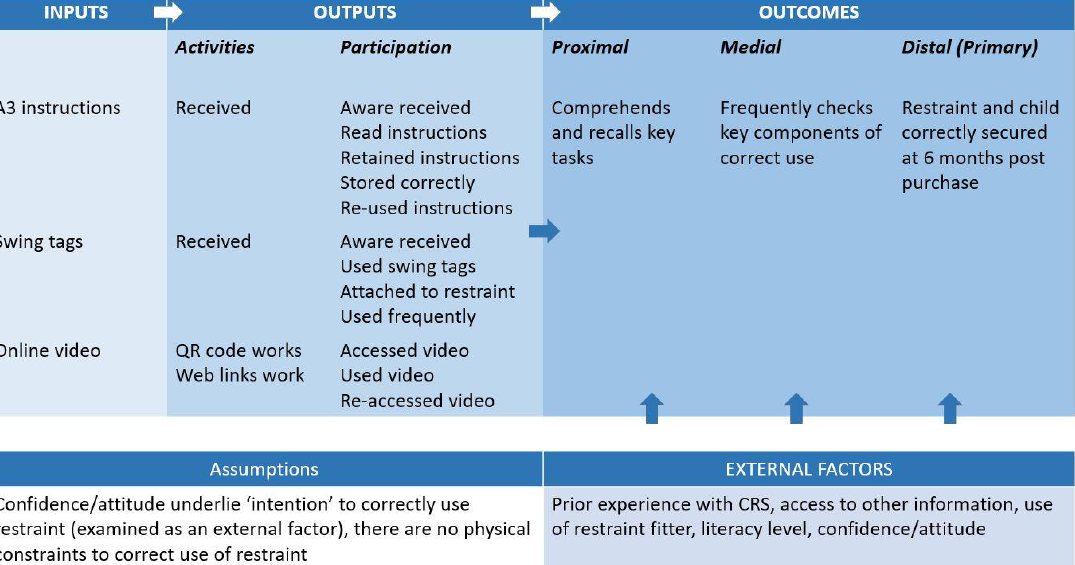
Figure 1. Logic model describing the hypothesised relationship between the intervention being tested and the primary trial outcome, the correct use of the restraint at six months post-purchase.